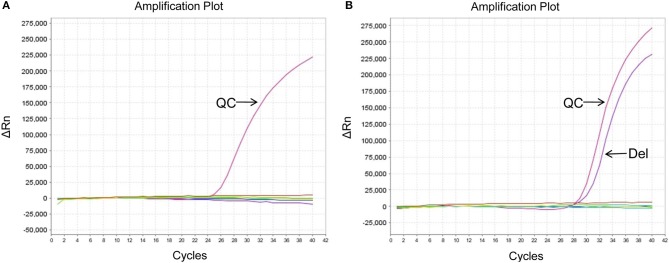
EGFR mutation status of patient No.17 using different sample types. (A) Wild type in cell blocks. (B) Exon 19 Del in exosomes. ΔCt was defined as the difference between the Ct value of specific mutation type and QC. And it was considered positive for exon 19 Del when ΔCt was <7. QC, quality control (a house-keeping gene).